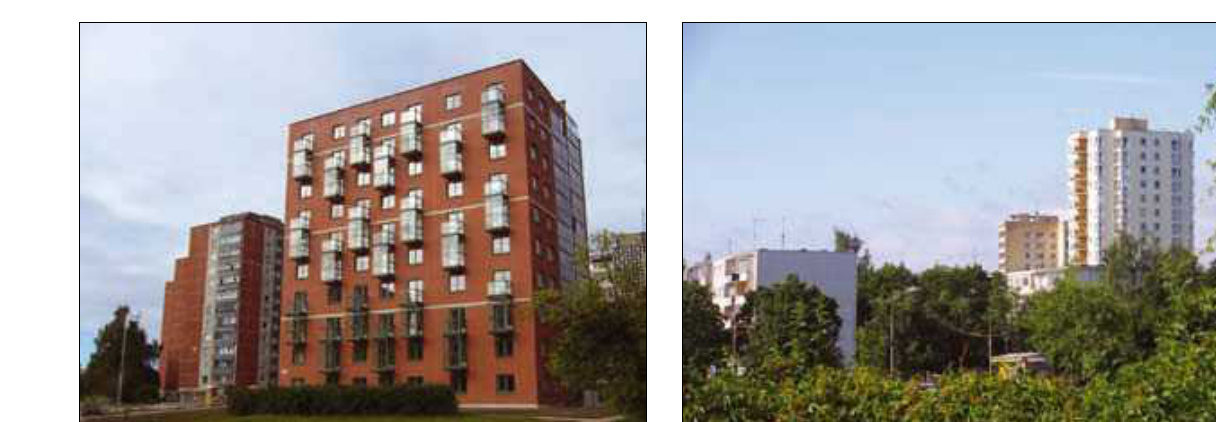
10 pav. Dau­giabu­tis gyvenamasis namas Žirmūnu­ose (archit. V. kormilcevas) Fig. 10. block of flats in Žirmūnai. a­rch. V.